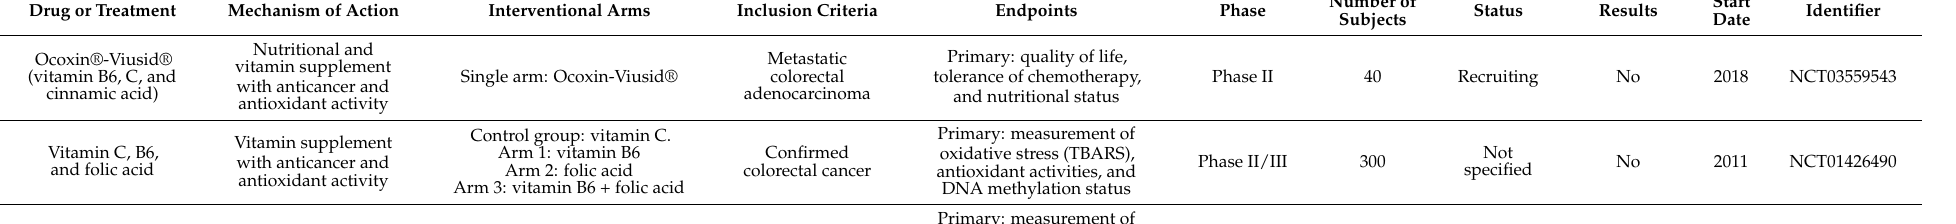
Table 2. Interventions or supplementations diets with antioxidants in healthy volunteers or colorectal cancer patients in clinical trials (www.clinicaltrials.gov accessed on 12 August 2021). Drug or